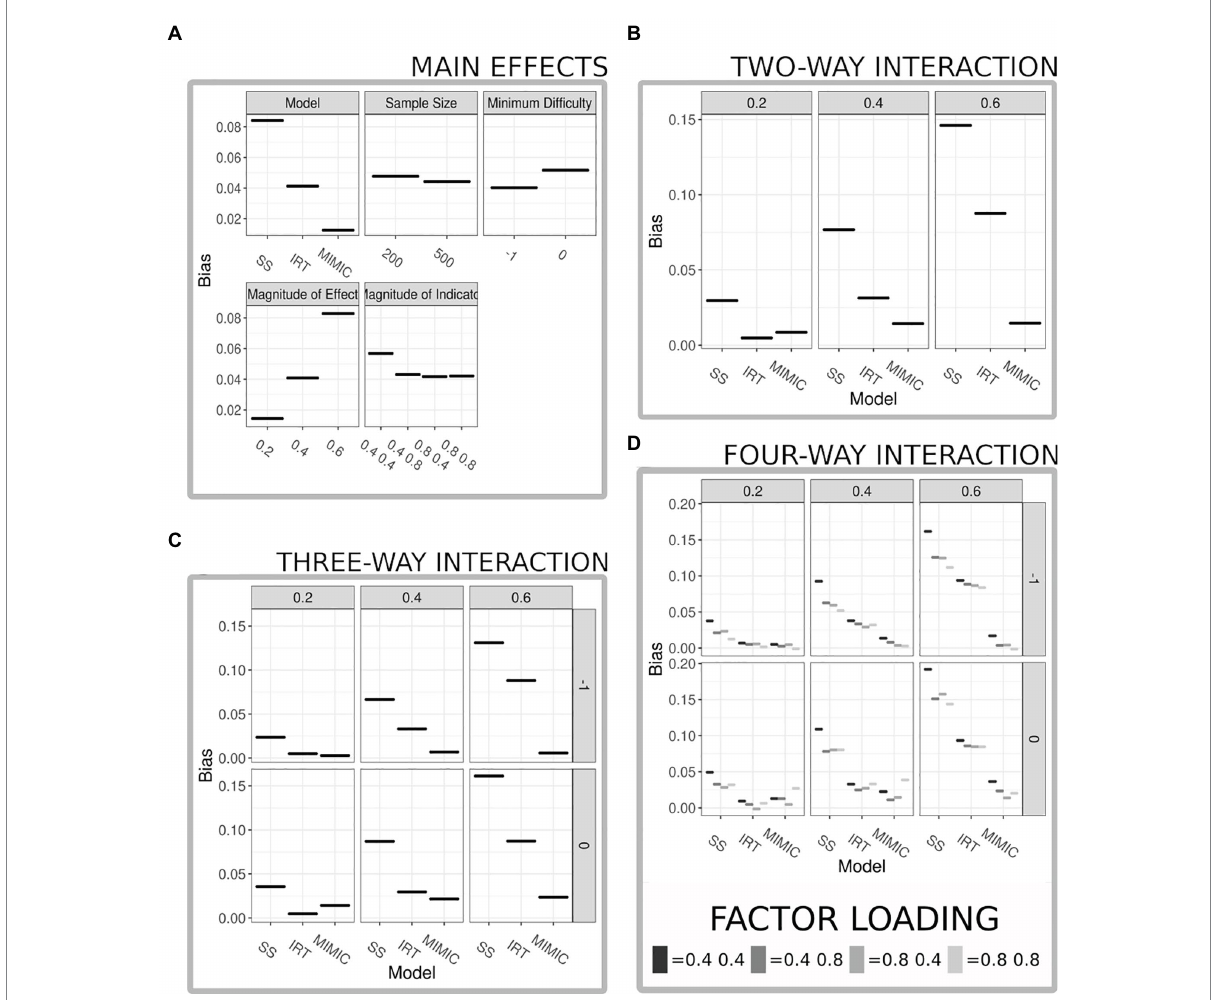
FIGURE 3 Results from ANOVA comparing bias in parameter estimates. (A) Displays the main effects from all variables included in the ANOVA model, panels are faceted by the variable, and the x -axis details the levels within each factor. (B) Displays the two-way interaction with the largest eta squared between the method used to summarize the behavior scores (model) and the magnitude of the true formative relationship, results suggest near equivalent performance when a weak formative relationship is present across the models, but as the relationship increases the MIMIC model’s bias remains much lower compared to that of the sum-score and item response theory (IRT) model. (C) Displays a three-way interaction with the largest eta squared between the methods used to summarize the behavior scores (model) the magnitude of the true formative relationship, and the range of difficulty of the items results extend the logic of the two-way interaction but emphasize the reduction in bias when the difficulty parameters cover a greater majority of the range of ability estimates present in the data. (D) Displays a four-way interaction with the largest eta squared between the method used to summarize the behavior scores (model), the magnitude of the true formative relationship, the range of the difficulty parameters, and the magnitude of the indicator variable